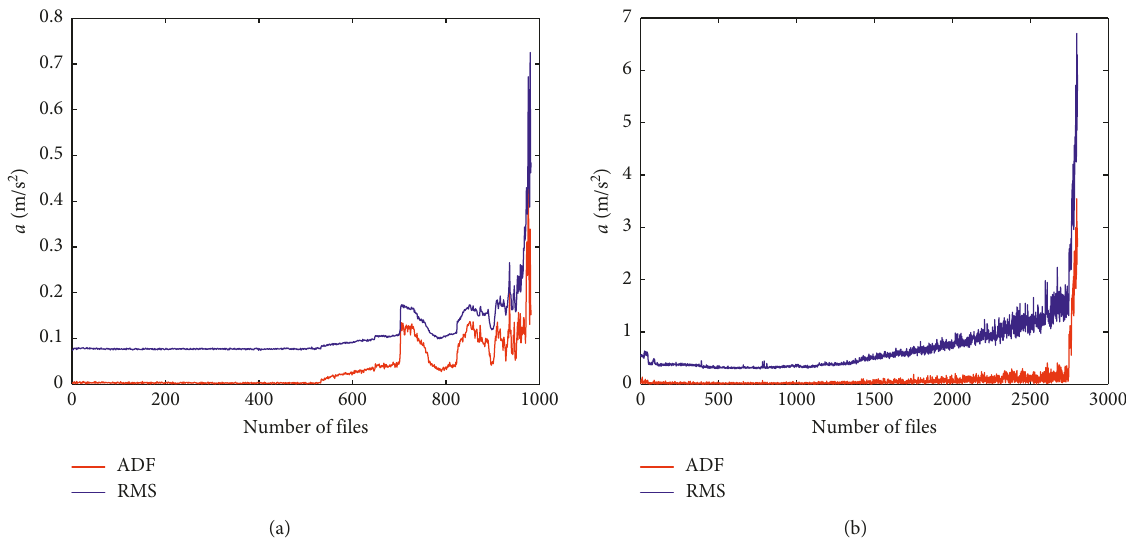
Figure 13: The ADF of (a) Case I and (b) Case II compared with